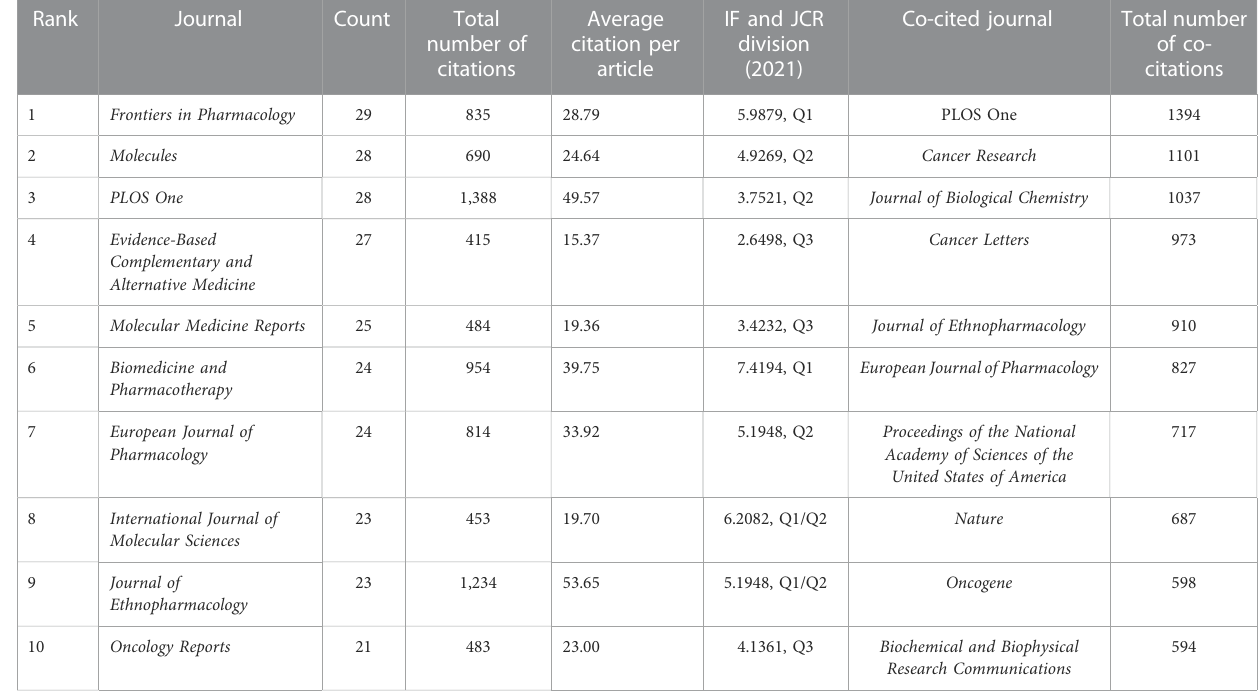
TABLE 4 Top 10 journals and co-cited journals that published articles on BBR and